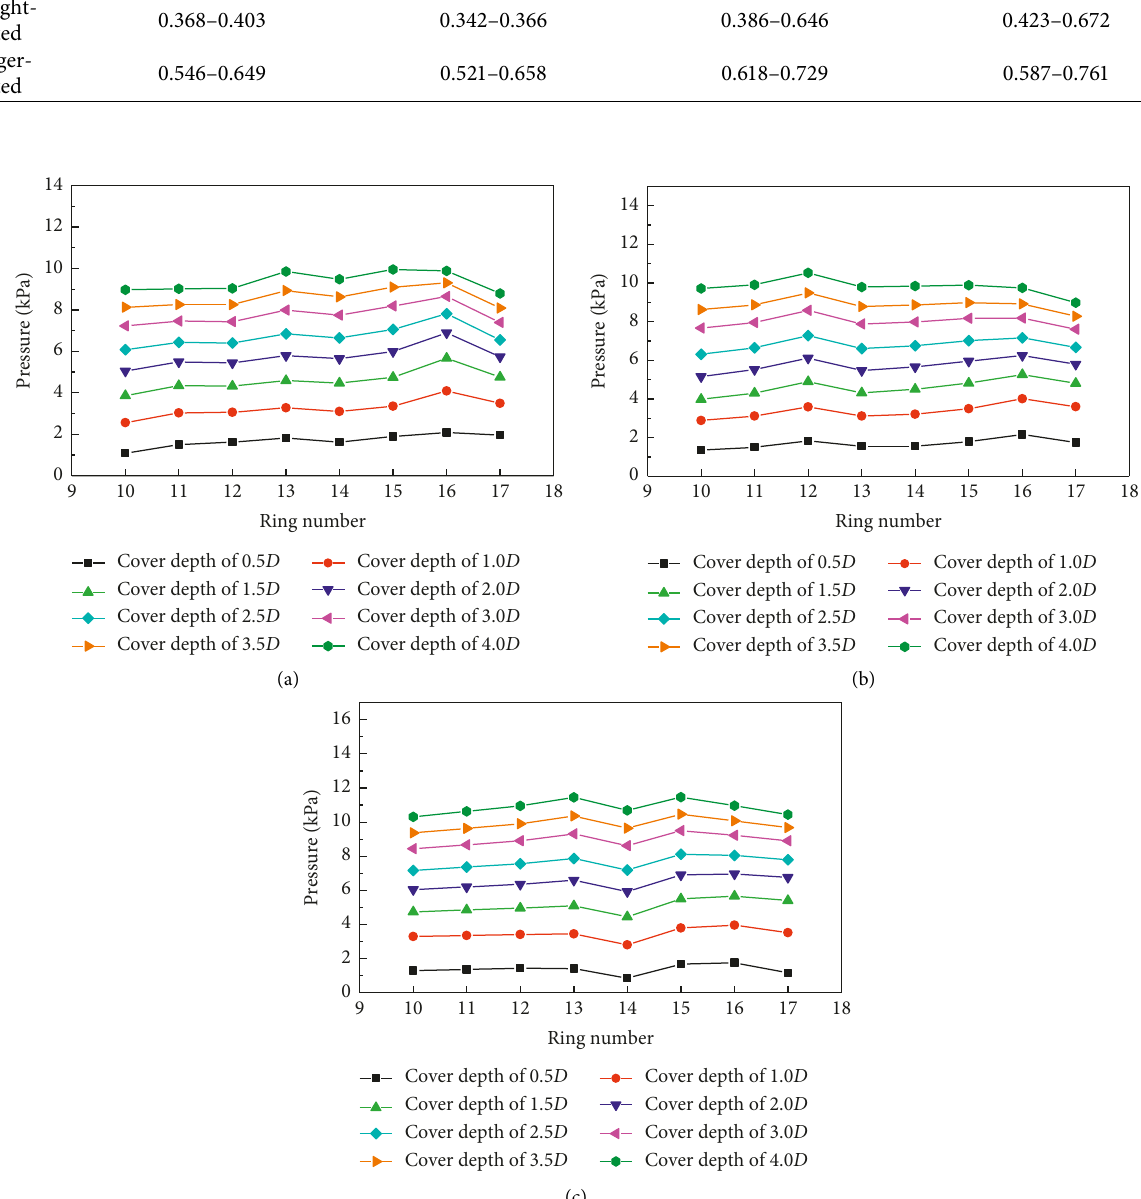
Figure 10: Earth pressures acting on the tunnel crowns of different rings under the realistic loading conditions. (a) Straight-jointed ring. (b) Stagger-jointed ring. (c) Uniform